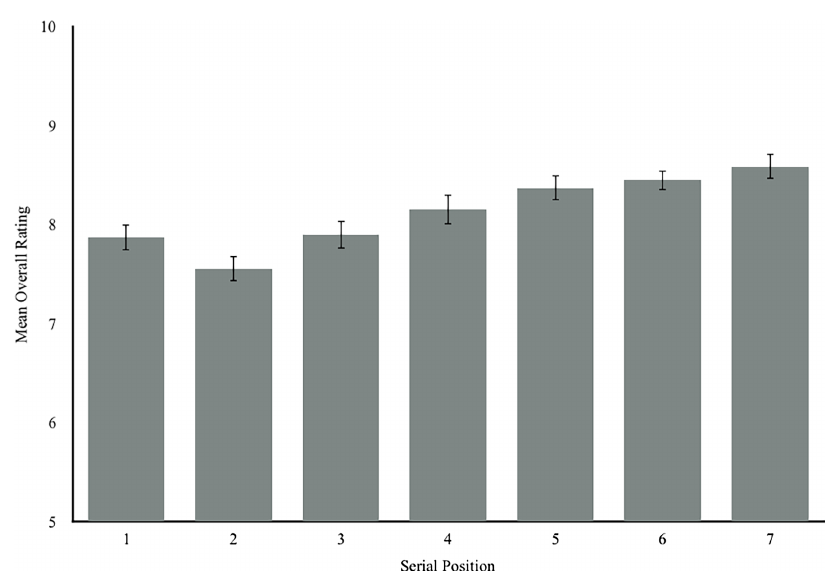
Fig 2. Mean overall rating given to whiskies in each serial position at tastings. Error bars represent 95% confidence intervals of the mean.